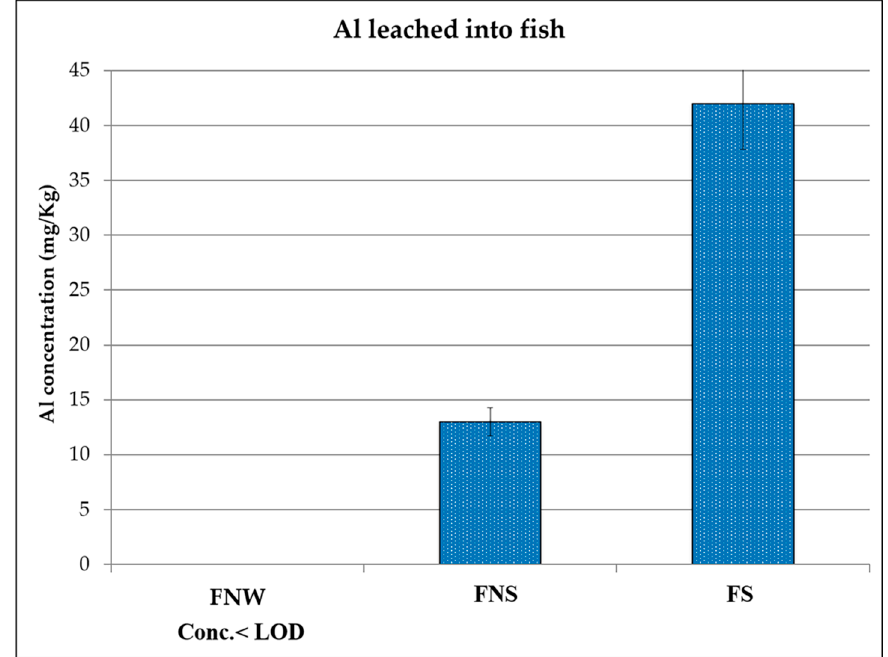
Figure 3. Aluminum concentration detected in fish baked without wrapping in aluminum foil (FNW), fish baked in aluminum foil without seasoning (FNS), and fish baked in aluminum foil with some seasoning (FS). LOD: limit of detection.